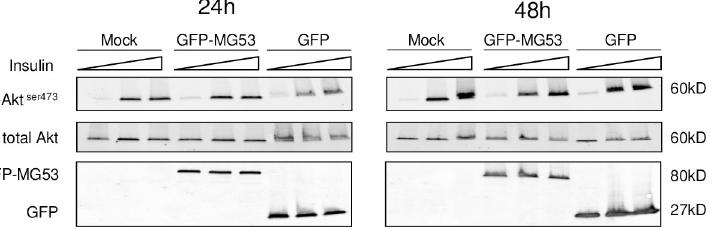
Fig 4. MG53 over-expression does not affect insulin response in HEK293 cells. HEK293 cells were transfected with a MG53 expression plasmid or GFP as control. 24h (left panel) or 48h later (right panel), cells are exposed to increasing concentrations of insulin (10 and 100nM) for 15 minutes. Insulin response was then evaluated using phospho Akt levels.